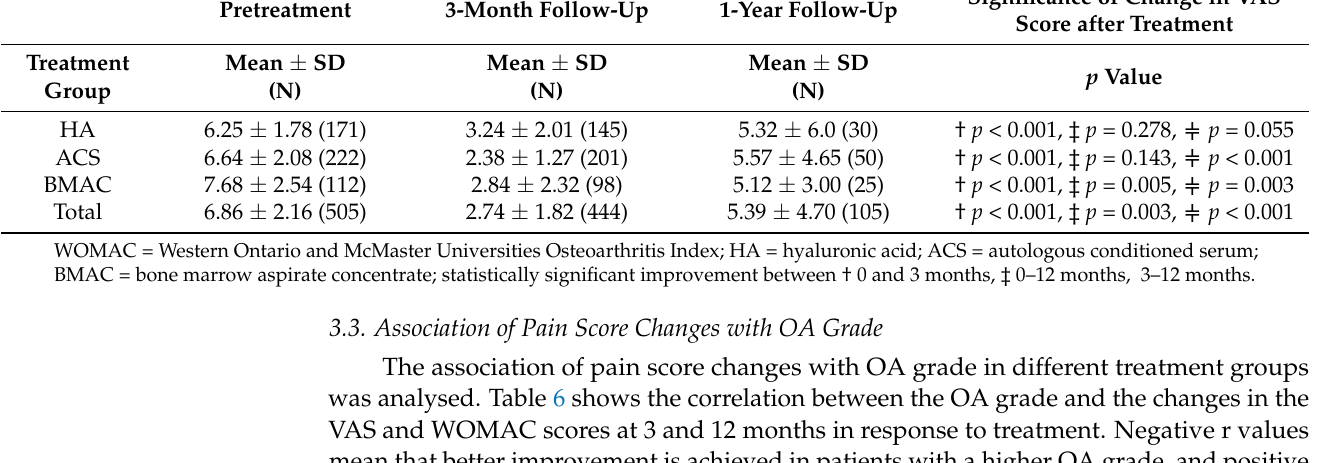
Table 3. Correlation between grade of OA and preintervention VAS and WOMAC score, respectively. Correlation between OA Grade & VAS Correlation between OA Grade & WOMAC Treatment Group Spearman Correlation Coefficient (r)